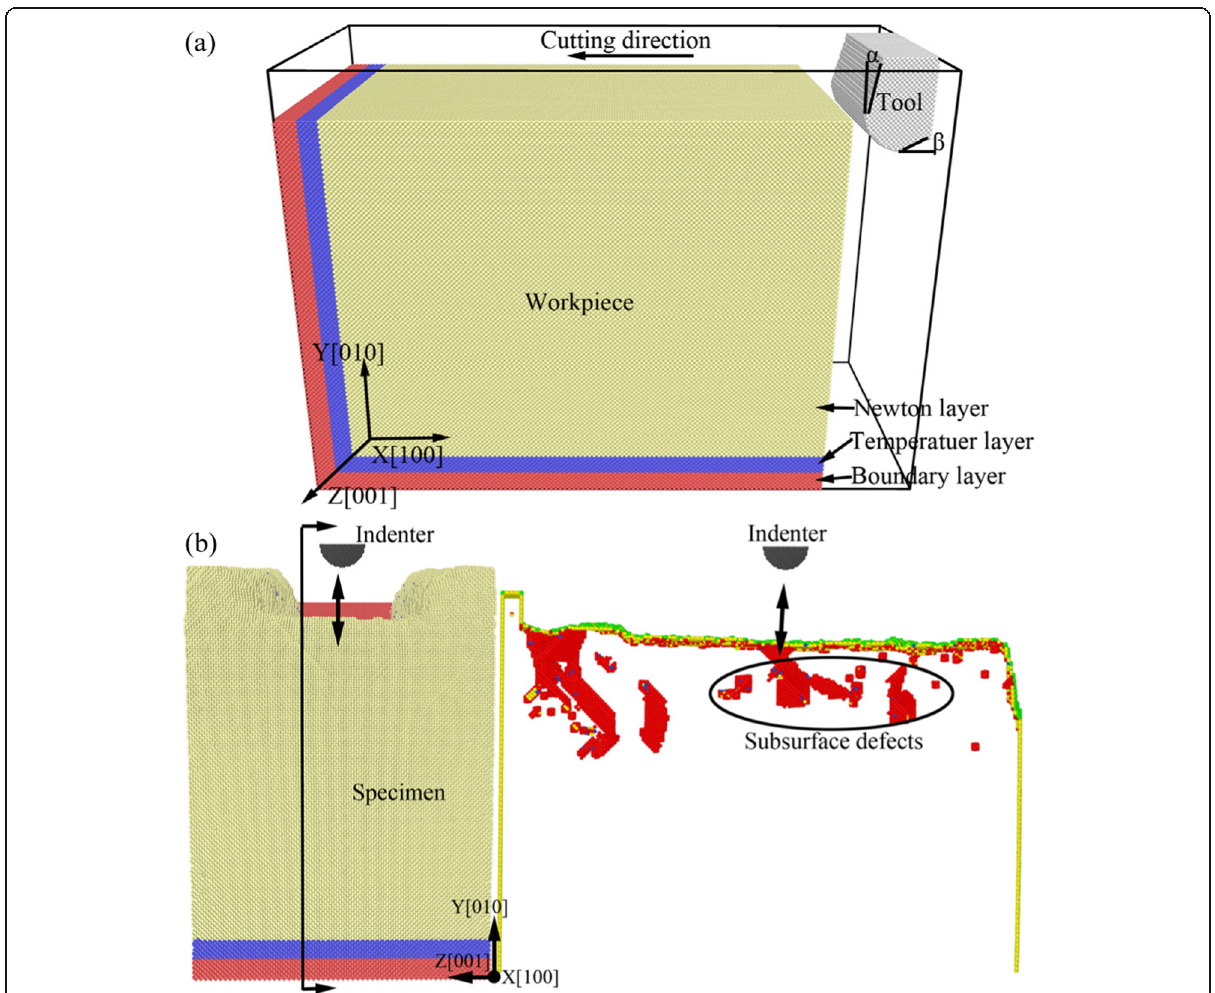
Fig. 1 Schematic diagram of 3-D MD simulation models of single crystal copper for nano-cutting and nano-indentation. a The model for nano- cutting process. b The model for nano-indentation process with subsurface